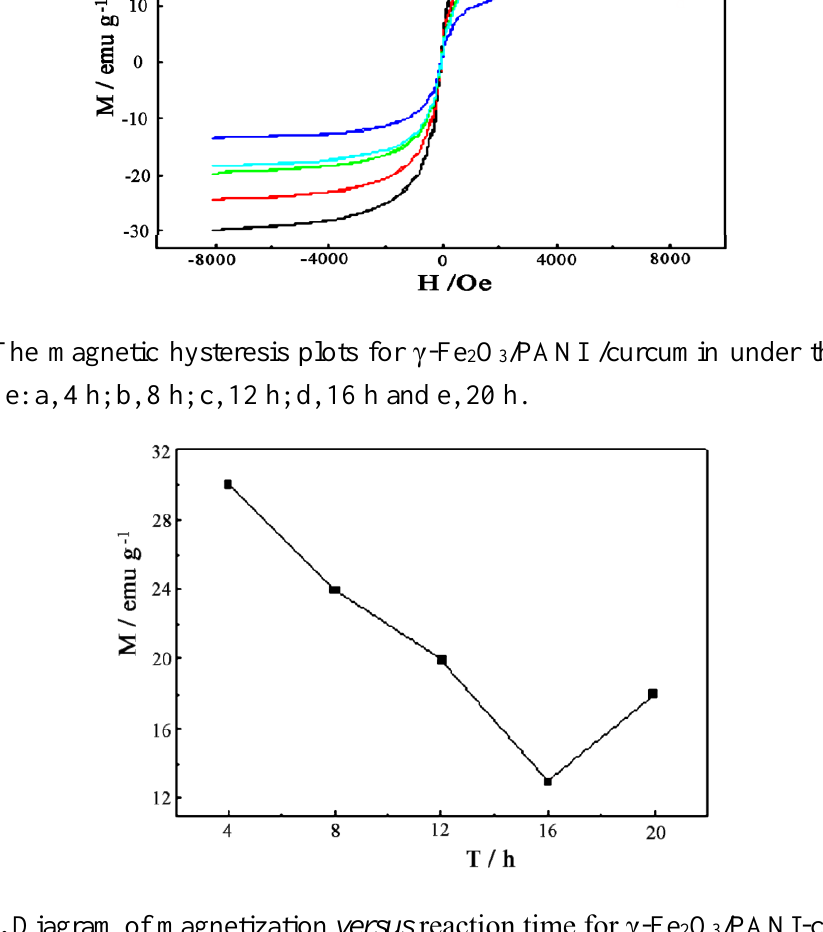
Figure 8. Diagram of magnetization versus reaction time for γ-Fe 2 O 3